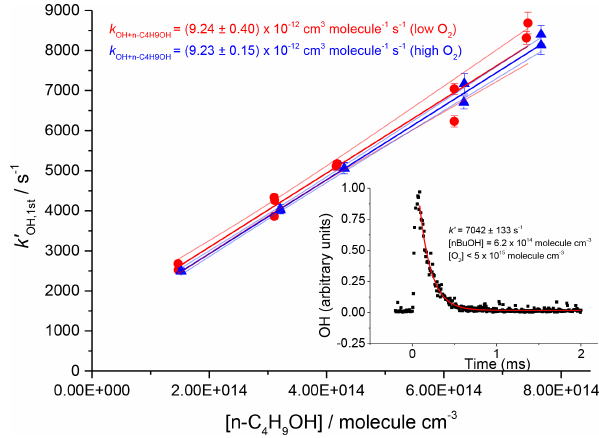
Figure 9. Plots k (cid:48) OH , 1st against the concentration of butanol, at two oxygen concentrations, < 5 × 10 15 and 1 . 2 × 10 19 molec.cm − 3 . Bimolecular rate coefficients were taken from the slopes as ( 9 . 24 ± 0 . 40 ) × 10 − 12 cm 3 molec. − 1 s − 1 under low-oxygen condi- tions (red circles with 95% confidence limits), and ( 9 . 23 ± 0 . 15 ) × 10 − 12 cm 3 molec. − 1 s − 1 under high oxygen conditions (blue trian- gles with 95% confidence limits). The inset shows a typical OH temporal profile at the first detection